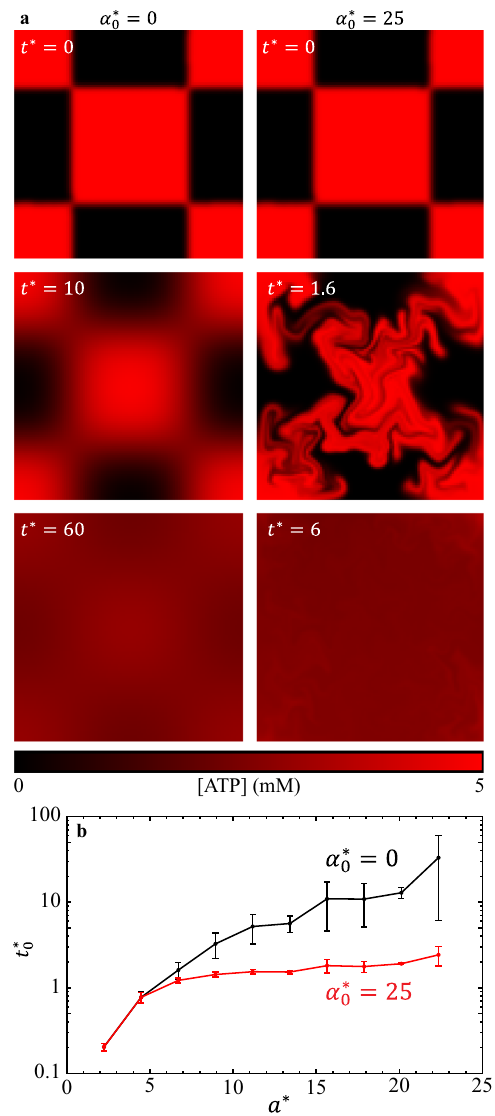
Fig. 8 | (Modeling results) Simulations with ATP initially distributed in a checkerboard pattern in a 45 × 45 simulation box. a Distributions of ATP (red) disperse from the checkerboard pattern (Eq. 11 with a * = 22) to a homogeneous state by molecular diffusion only (left; D * = 1, α * 0 = 0) and by the combination of molecular diffusion and active fl uid-induced convection (right; D * = 1, α * 0 = 25). b The dimensionless mixing time of ATP increases monotonically with the dimensionless checkerboard grid size a * in both active (red) and inactive (black) fl uid systems. Error bars represent the standard deviation of two trials performed with different types of checkerboard pattern (Eq. (11) and